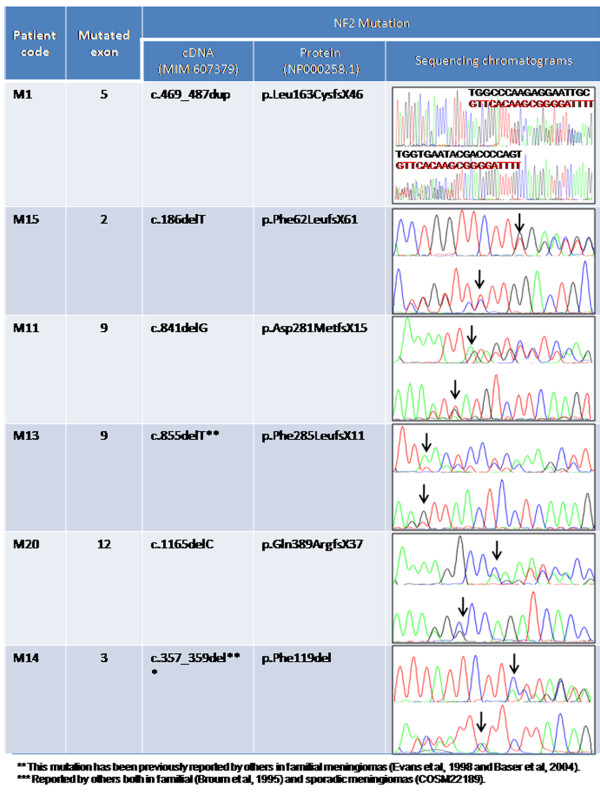
NF2 mutations. Detailed description of the 6 NF2 mutations (a 19 bp duplication and 5 deletions) identified among the 20 meningiomas analyzed, including the position of the alterations identified, the potential effect of each mutation and their sequencing chromatograms (the positions of the deleted base(s) are indicated with an arrow).